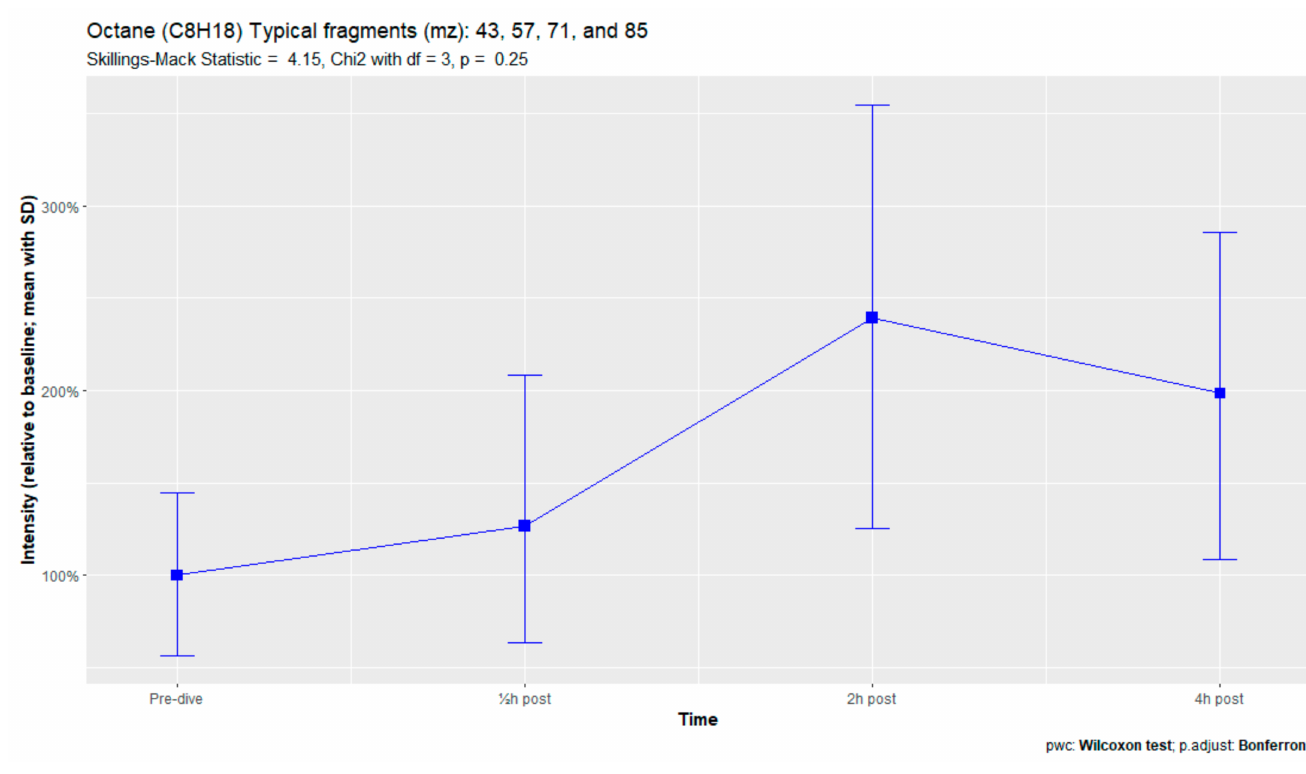
Figure A9. Octane.